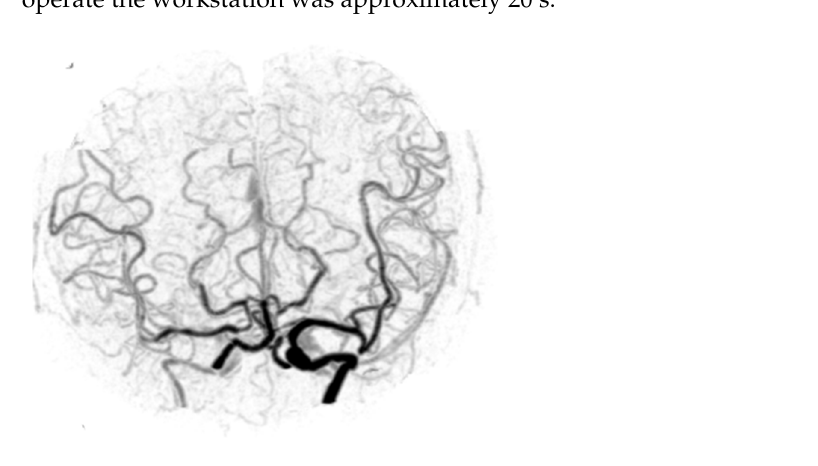
Figure 3. Cut-out Towne-view W4D-CTA image of Case 8. W4D-CTA, whole-brain four-dimensional computed tomography angiography.